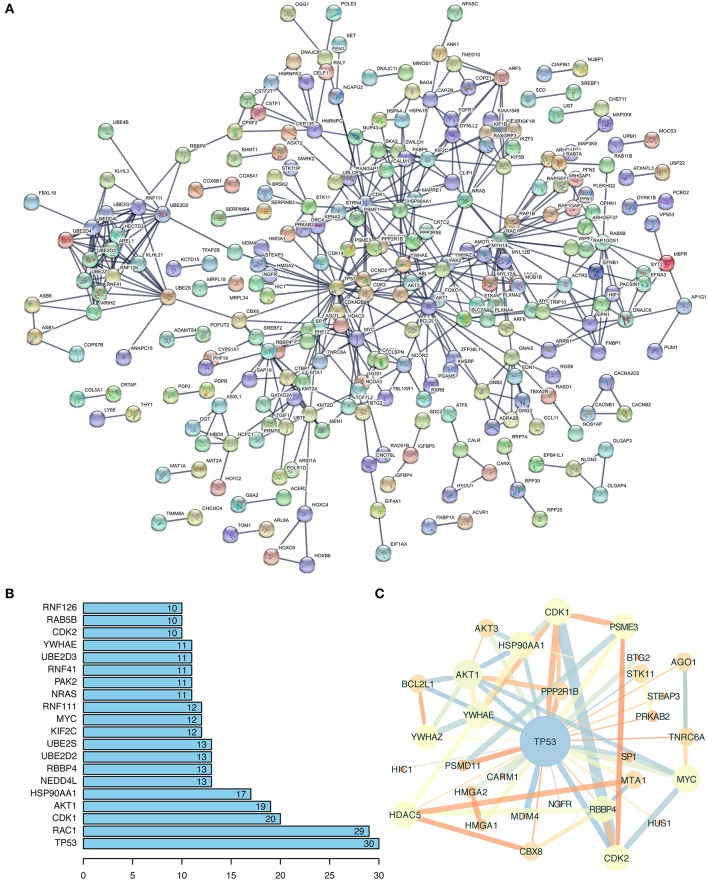
Function annotation of potential targeted genes. (A) The analysis results of Protein-Protein Network (PPI) from String Database (https://string-db.org). The disconnected nodes were hided. The line thickness indicated the strength of data support, including experiments, text-mining, databases, co-expression, neighborhood, gene fusion, and co-occurrence. (B) The top 20 interactive genes were exhibited, indicating the correlation degree with other genes. (C) The TP53-related network extracted from (A) using the MCODE plugin in Cytoscape (version: 3.7.1). The wider the edge and circle size, the larger the co-expression, and MCODE-scores are; the brighter the color, the lower the MCODE-score, and combined-score are.